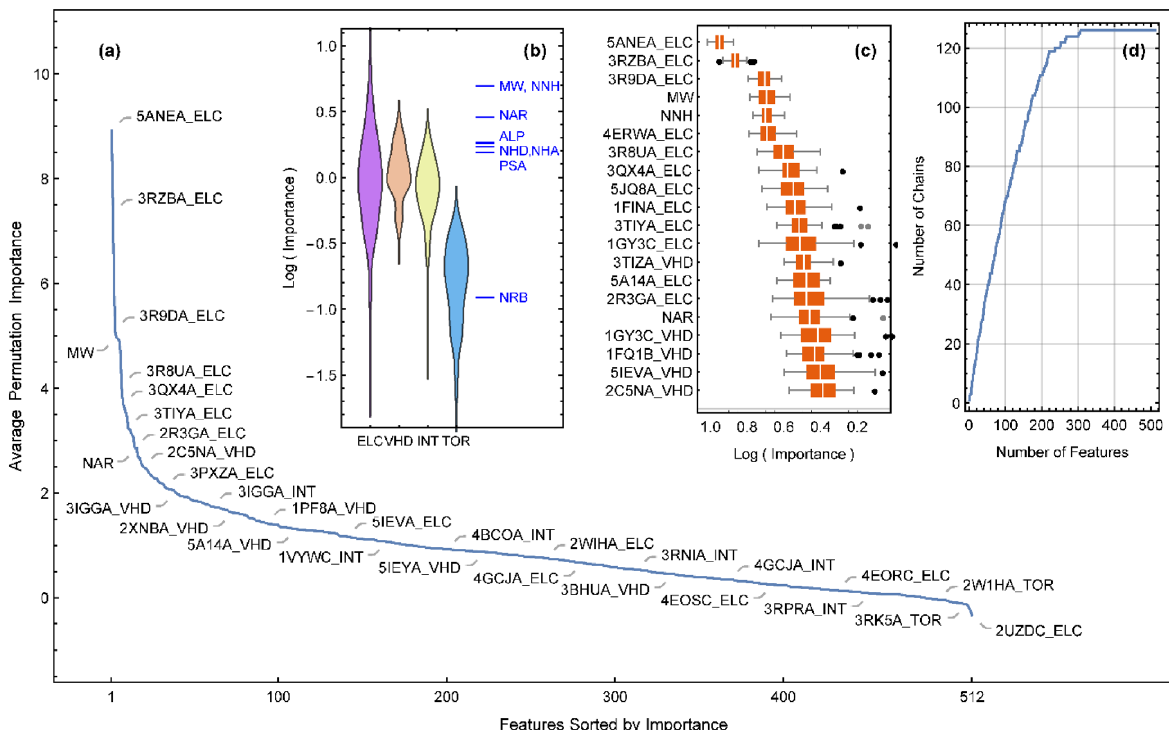
Figure 6. ( a ) Permutation importance of all 512 docking and molecular features averaged over repeats with different random seeds. ( b ) Distribution of average permutation importance of different physical contributions of docking features obtained by aggregating contributions from all receptors. The vertical lines correspond to the average importance of simple molecular features. ( c ) Distribution of permutation importance values of 20 most important features. ( d ) Enumeration rate of receptor chains against features sorted by permutation